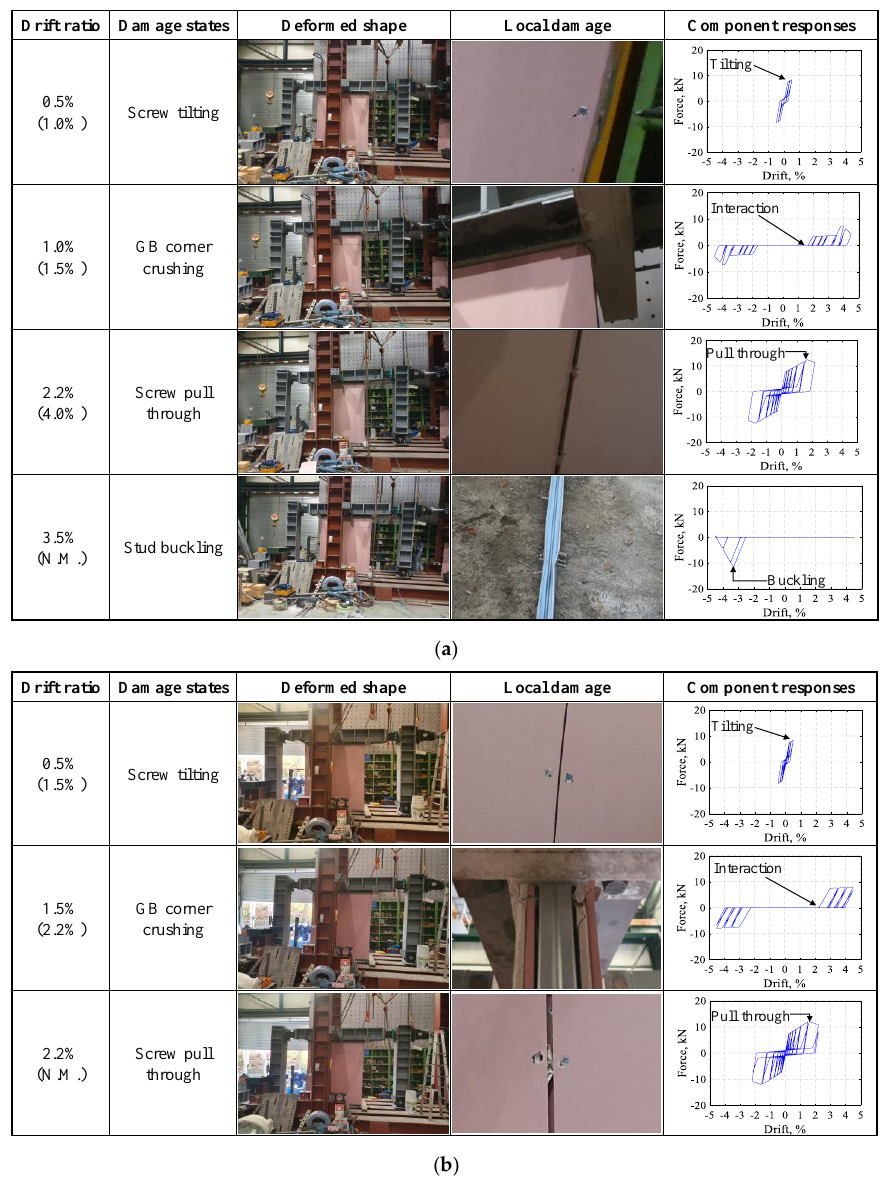
Figure 17. Comparison of analytical and experimental damage states: ( a ) ST600; ( b ) ST450. Differences of damage to other components between the ST600 and ST450 specimens was negligible. During the tests, crushing or breaking of GBs at the corner of wall panels occurred in both the specimens in drifts ranging from 1.5% to 2.2% corresponding to 50th percentile spots of the GB corners damaged. The predicted damage mechanisms include the interaction between GBs and concrete slabs. The initial gaps of GB-to-slab connections were analytically closed at 1.5% and 2.2% drift ratios and crushing strengths reached at 2.0% and 3.0% drift ratios for the ST600 and ST450 specimens, respectively. Although the analytical model produces a slight difference in the contact initiation, it can reasonably simulate the nonlinearity of the force–displacement relation at the GB-to- slab connection. The analytical model of studs installed in the ST600 specimen captures the interaction of the boundary stud-to-track connection at a 2.5% drift ratio and the bearing strength is developed due to such interaction. Rapid strength degradation in the force–displacement relation occurred at a drift ratio of 3.5% of drift, which resulted from the damage states such as local buckling and bending of studs. These damage mechanisms of studs are consistent with the observed damages in the experiment. The damage-to-drift correlation obtained from this study is compared to results of previous experimental studies [34,35], of which the specimens were similar to those utilized in this study. As shown in Figure 18, screw tilting and stud buckling were, respectively, observed on 0.40% and 1.9% of drift ratios which are almost identical to those measured at the ST600 specimen. The noticeable difference is the occurrence of corner crushing of GBs. The early occurrence of crushing of GBs in this study results in the use of smaller gaps between the edge of GBs and slabs, and between the CFS stud and top tracks than used in the previous studies. Figure 18. Damage-to-drift ratio relation of the reference specimens (from Pali et al. [34], Fiorino et al. [35].